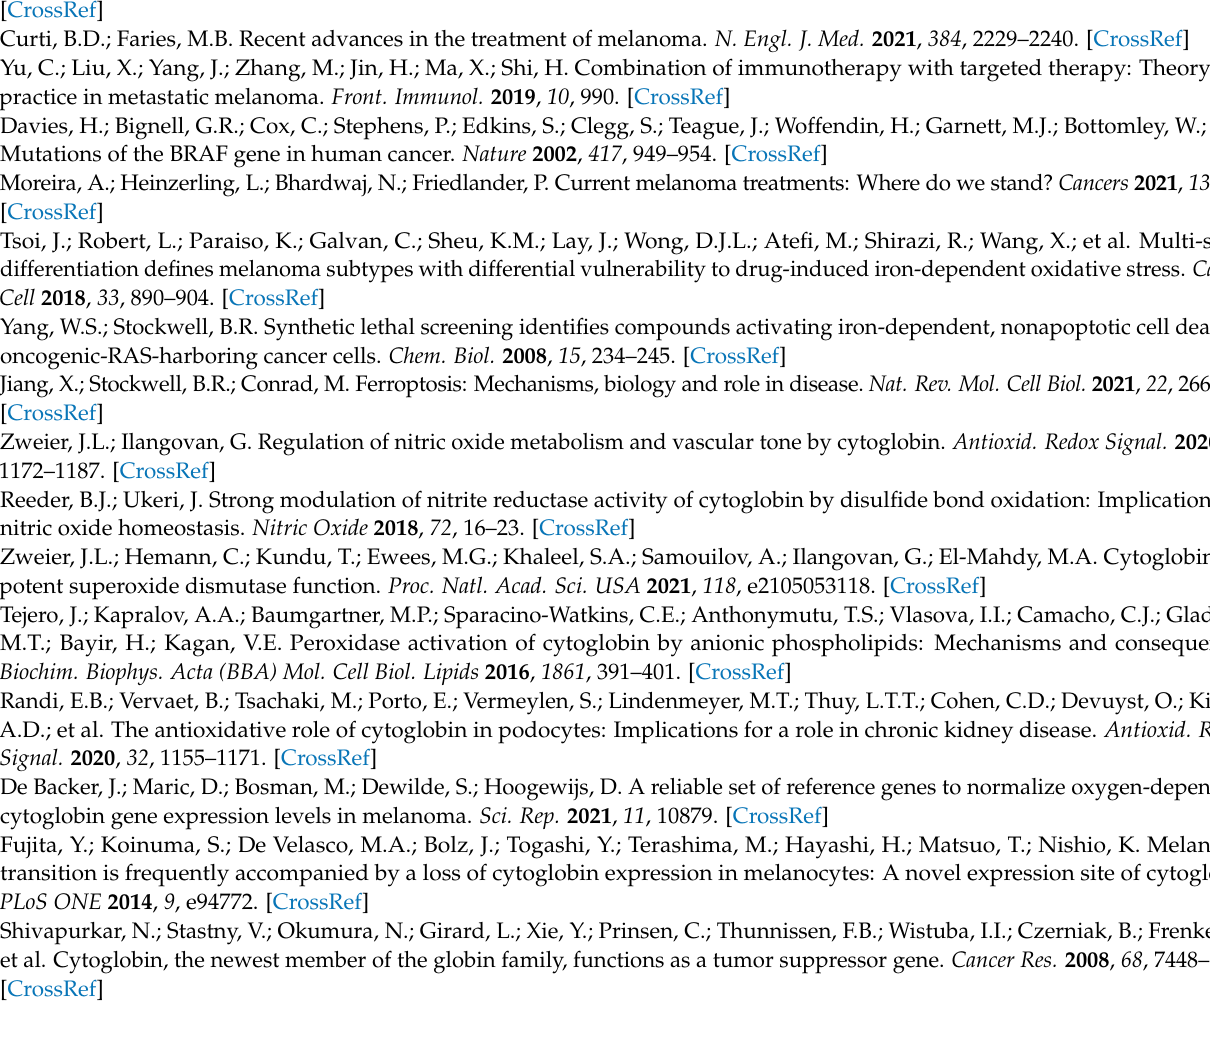
Table S1: Primer sequences of used